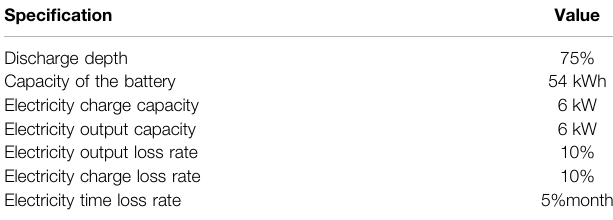
TABLE 4 | Speci fi cations of the storage battery. Speci fi cation